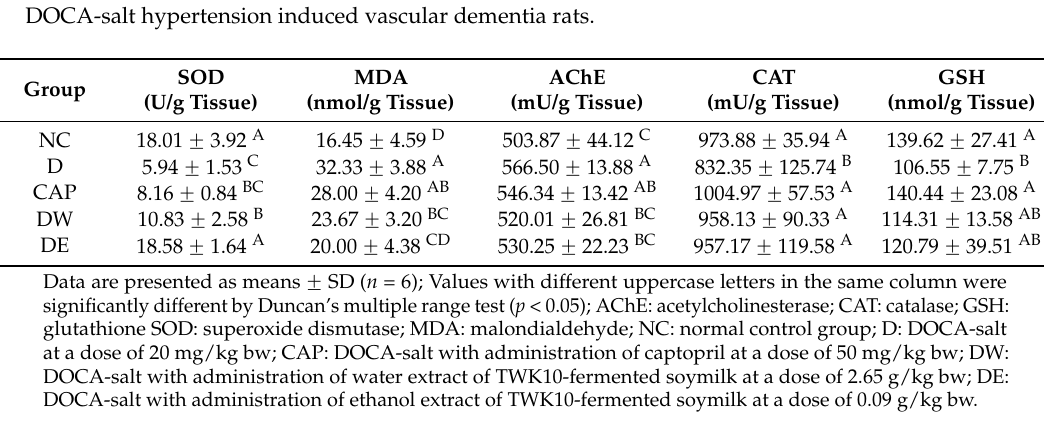
Table 7. Effects of administration of the extracts of TWK10-fermented soymilk on ACE activity in lung and kidney, angiotensin II and nitric oxide concentration in plasma of DOCA-salt induced hypertension and its associated dementia rats.